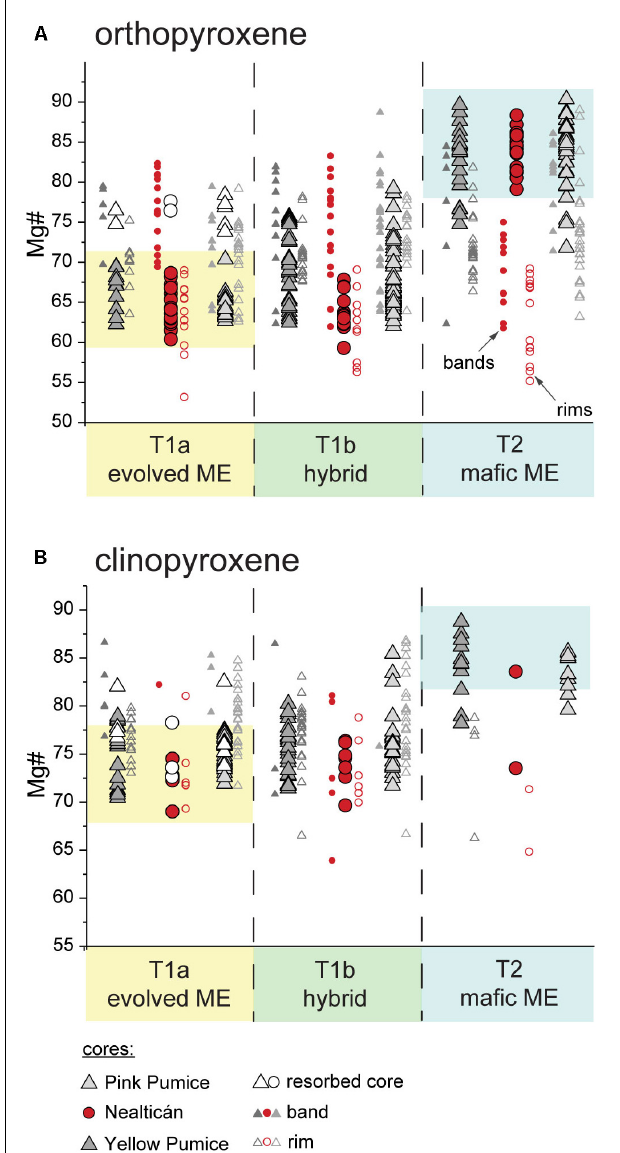
FIGURE 5 | Compositional classification of T1a, T1b, and T2 pyroxenes in the Yellow Pumice Plinian eruption (YP), the Nealticán flank eruption, and the Pink Pumice Plinian eruption (PP). (A) orthopyroxene; (B) clinopyroxene. T1a crystals represent the shallow evolved ME (magmatic environment; yellow), T2 crystals the shallow mafic ME (blue), and T1b are hybrid products (green) similar to bands and rims around all types of pyroxene. Shaded fields designate typical compositional ranges for the different types of pyroxene. See text for